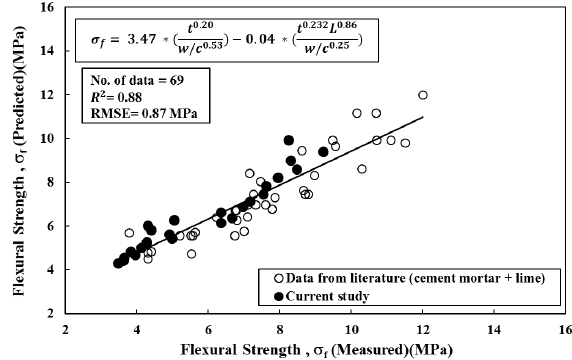
Figure 12: Comparison between measured and predicted of flexural strength for cement mortar modified with lime